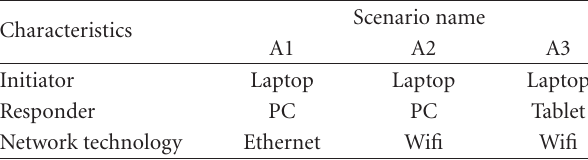
Table 1: Subscenarios A1, A2, and A3 features.